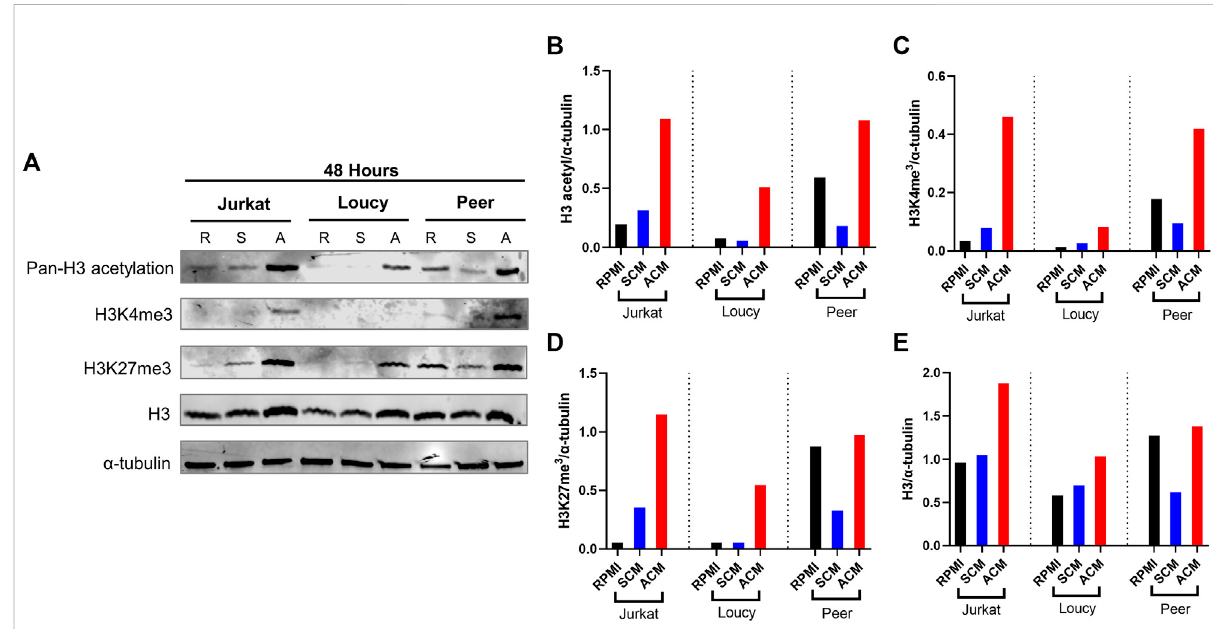
FIGURE 4 Adipocyte secretomealters theepigenome ofhuman T-ALLcells. HumanT-ALL cells(Jurkat,Loucy, andPeer)werecultured inunconditioned media,SCM,orACMfor48 h,andWesternblotanalysiswasconductedtodeterminethelevelsofmodi fi cationsonhistone3(H3)andtotalH3levels. (A) Primary data from a Western blot experiment are shown. (B – E) Protein expression levels from Western blot experiments were determined using ImageJ analysis, and a representative blot from two independent experiments is